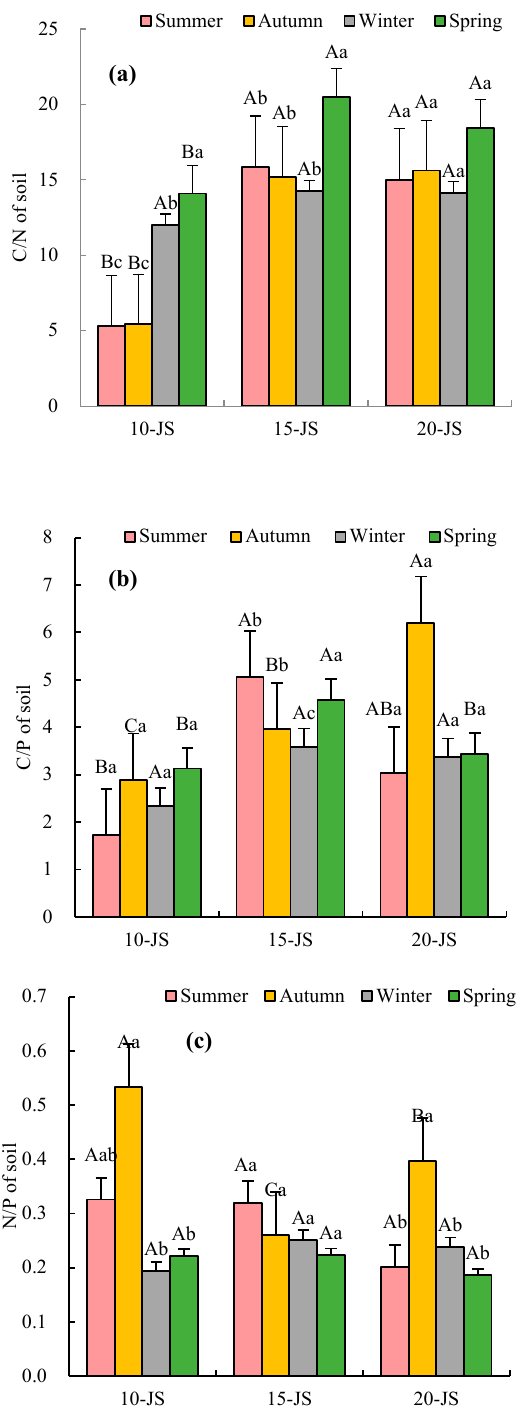
Figure 6. The C/N, C/P and N/P of soil under different precipitation patterns. Note: ( a ) C/N of soil, ( b ) C/P of soil, ( c ) N/P of soil; capital letters on different columns indicate that the soils in the same season were significantly different under different precipitation ( p < 0.05); lowercase letters on different columns indicate that the soils in the same precipitation had significant difference in different seasons ( p < 0.05).